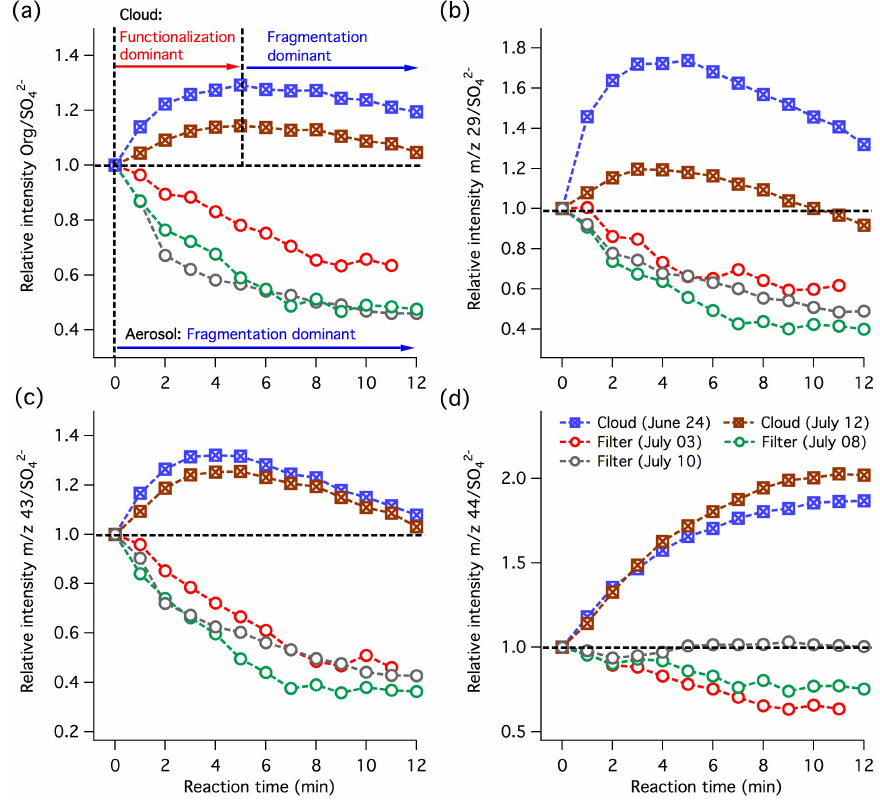
Fig. 5. Time series profiles of sulfate-normalized (a) Org/SO 2 − and cloud water samples due to aqueous-phase OH